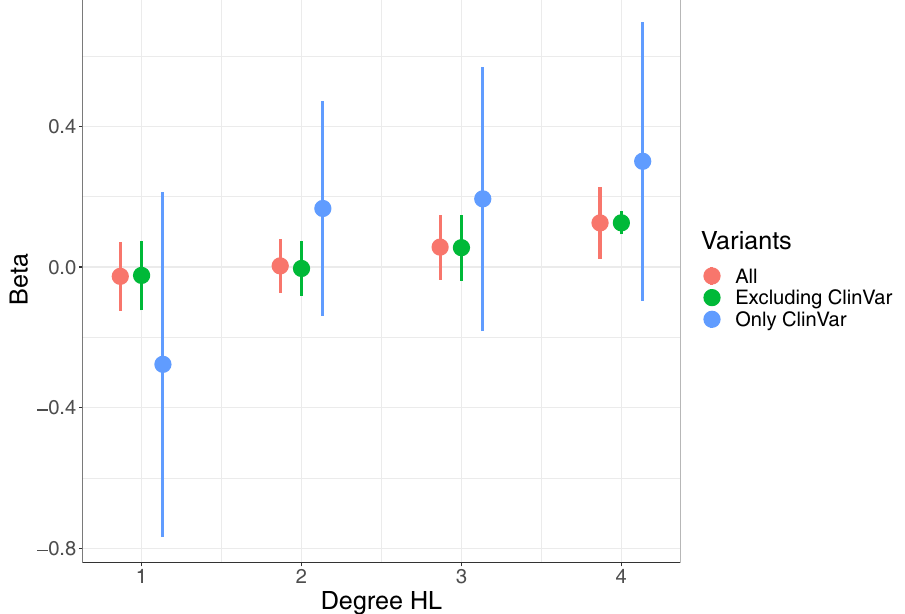
Fig 3. Effect estimates from logistic regression, testing individuals with degree HL 1–4 against individuals with degree HL 0 (including Phecode controls) in known HL genes (bars are 95% CI). Results are split by only including ClinVar variants, excluding ClinVar variants, and using all